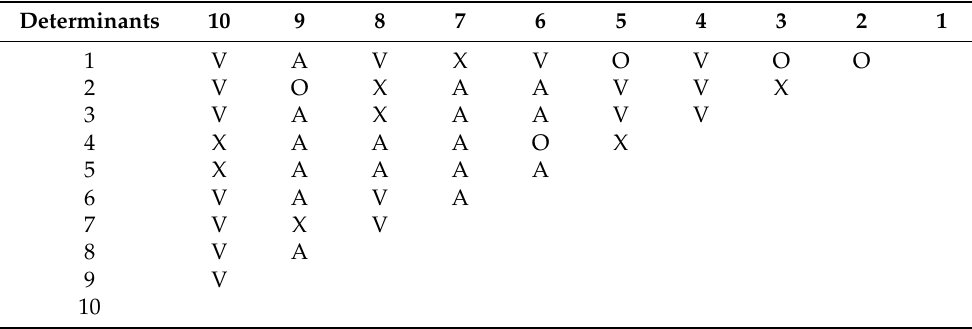
Table 2. SSIM for the determinants of logistic 4.0 adoption.